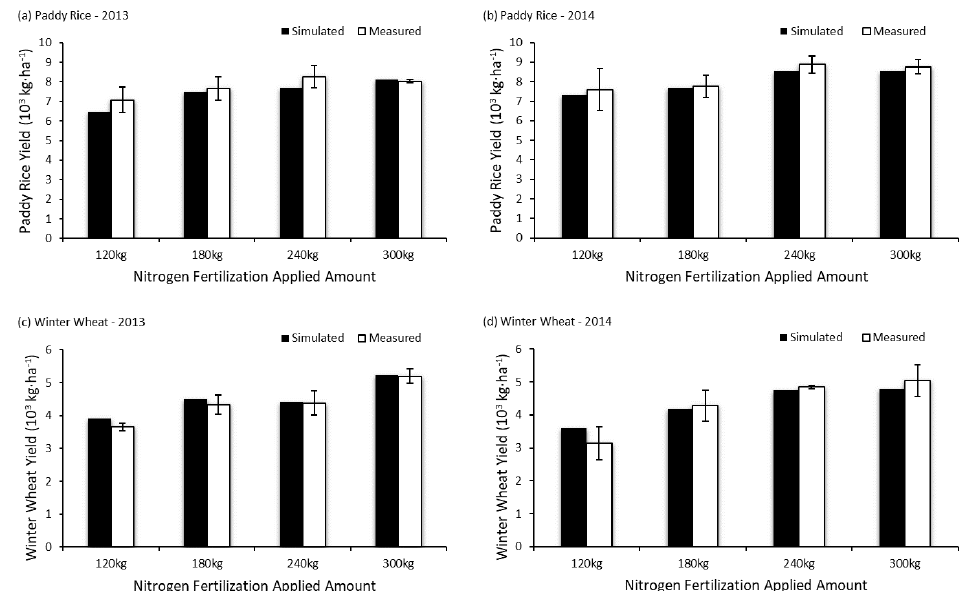
Figure 7. Comparison between simulated and measured crop yield in rice-wheat rotation system [23].